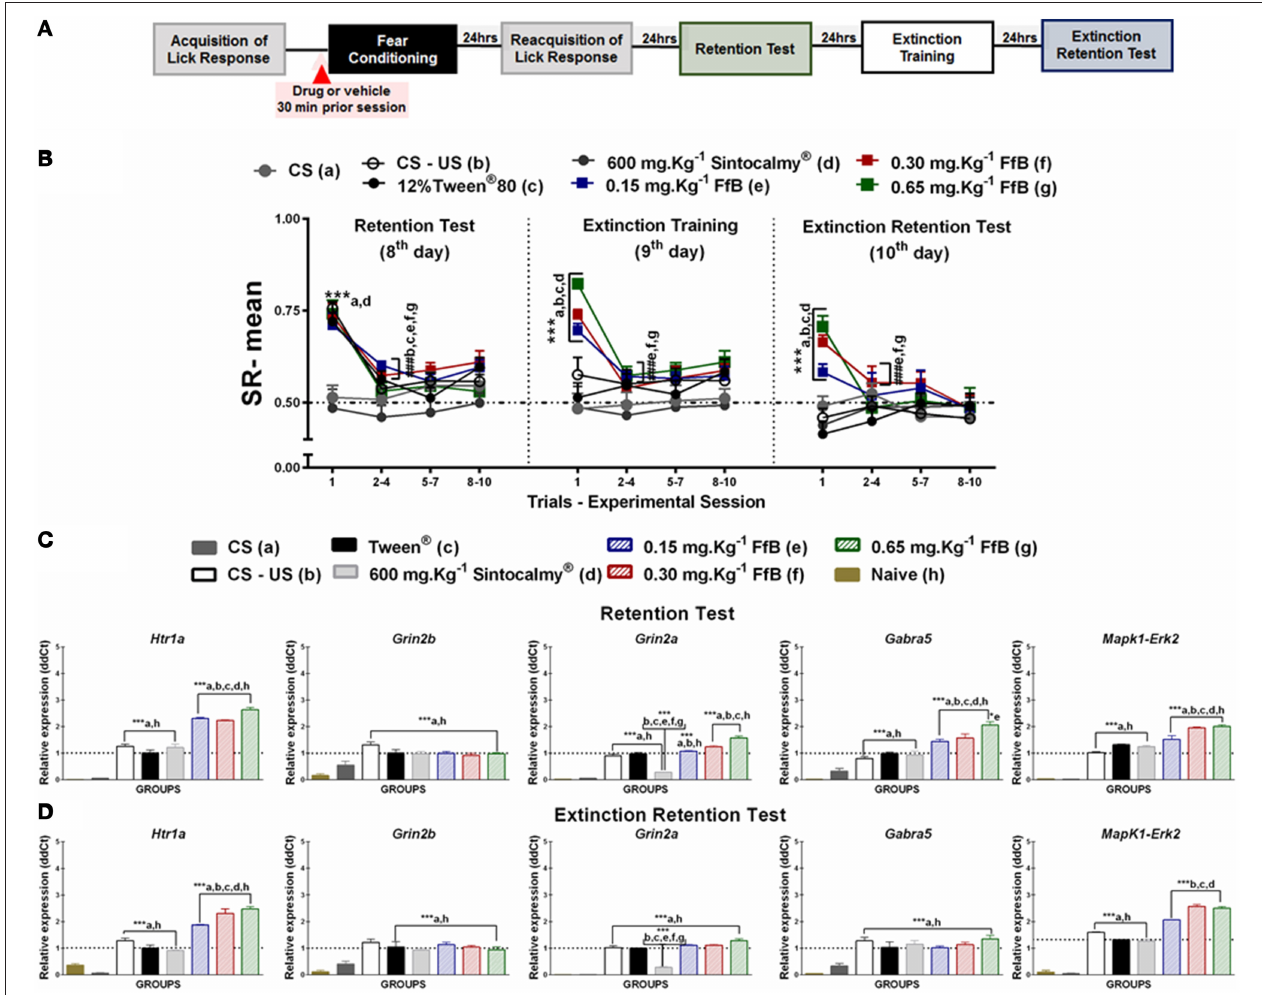
FIGURE 2 | (A) Timeline illustrating the time points of drug administration and brain removal. (B) Mean SR of licking behavior in the retention test session (8 th day, n = 20 /group), extinction training (9 th day, n = 10 /group) and the extinction retention test (10 th day, n = 10 /group). The first point indicates the mean SR for the CS, learning, Sintocalmy ® , Tween ® , 0.15mg.Kg − 1 FfB, 0.30mg.Kg − 1 FfB, and 0.65 mg.Kg − 1 FfB subgroups. The subsequent data points represent the mean of nine trials in blocks of three trials. The drugs and vehicle were administered orally 30min before the fear conditioning session; the CS and CS-US groups received no treatment. The data are reported as the means ( ± SEM). A repeated measures ANOVA was employed for the intra-group comparison of the retention test, extinction training and extinction retention test (CS presentation) results. This analysis was performed considering two fixed factors (group and trial) and one random factor (rat) using GraphPad Prism software. he relative Htr1a , Grin2b , Grin2a , Gabra5, and Erk2 mRNA expression levels in the DH after acute treatment with Sintocalmy ®